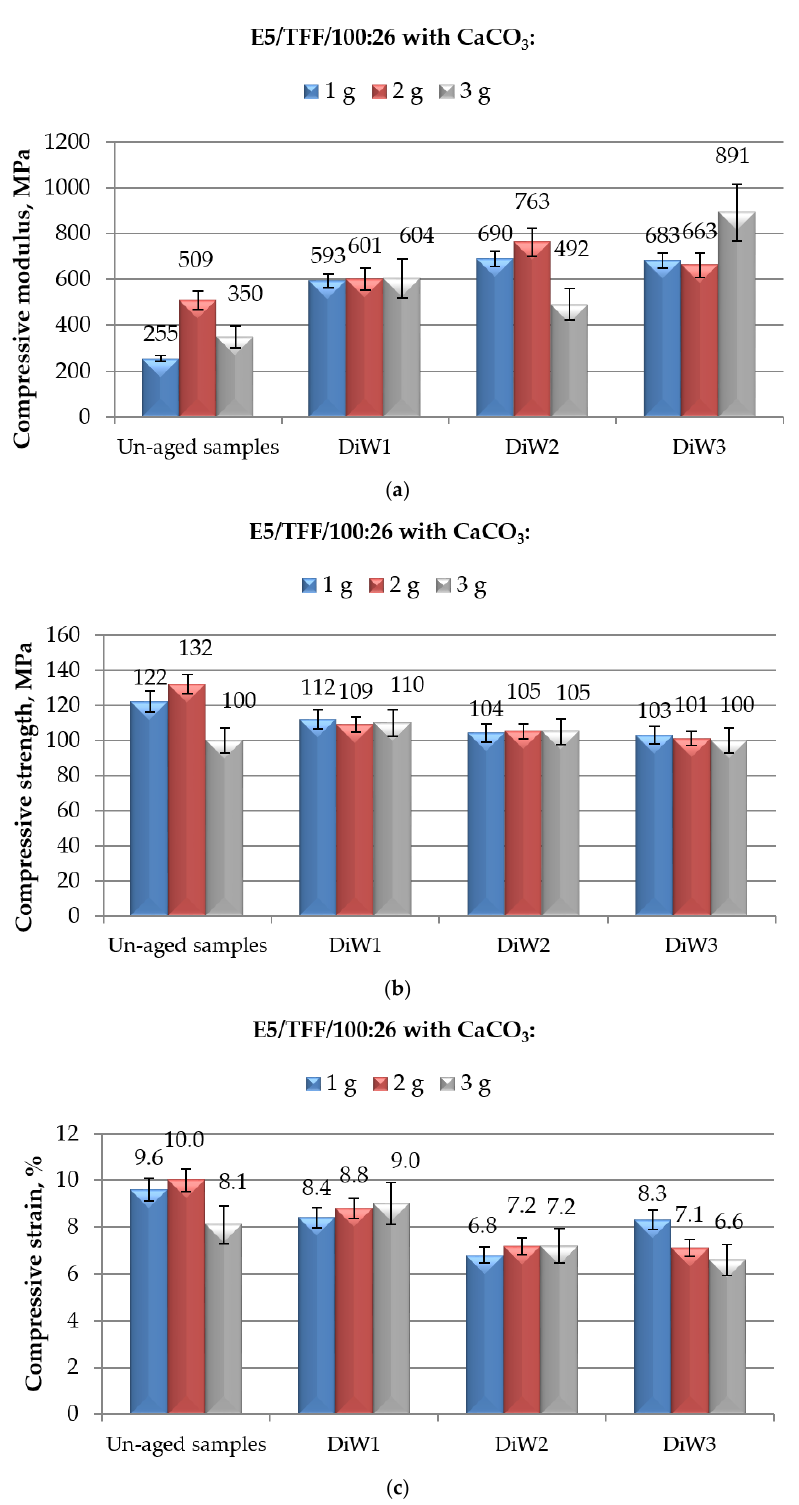
Figure 6. Results of mechanical (in compression mode) tests performed on E5/TFF/100:26 epoxy compounds filled with different amounts of CaCO 3 and aged for different time spans (from 1 to 10 months) in distilled water: ( a ) compressive modulus; ( b ) compressive maximum strength; and ( c ) compressive strain at break.